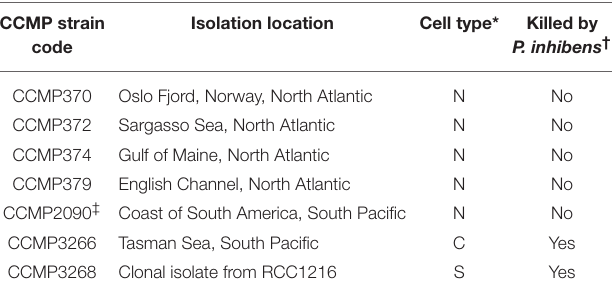
TABLE 1 | Axenic E. huxleyi strains and their susceptibility to P. inhibens pathogenesis. CCMP strain